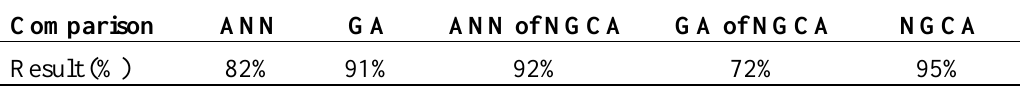
Table 3. Results using ANN, GA, ANN in NGCA, GA in NGCA, and NGCA.